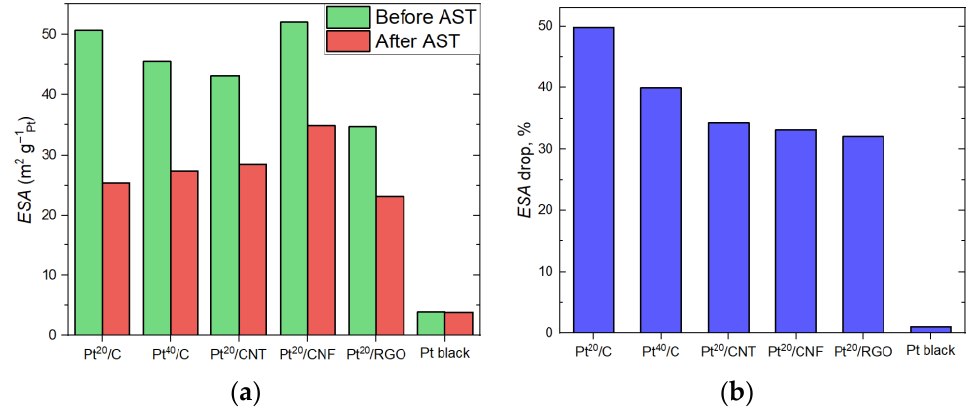
Figure 2. ESA values ( a ) and ESA drop ( b ) before and after 3000 AST cycles.